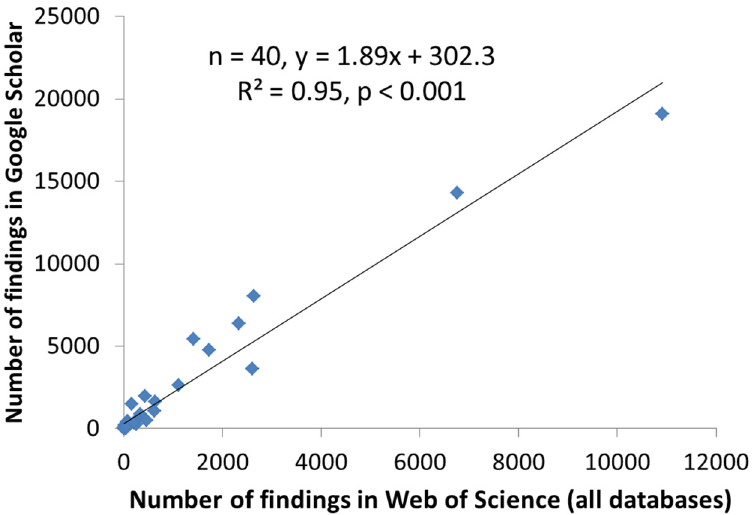
Figure 4. Correlation between number of findings in Google Scholar and Web of Science on the exotic tree pathogens reported in Switzerland up to October 2011 (as in [89], data kindly provided by Ottmar Holdenrieder, with addition of Hymenoscyphus fraxineus , the causal agent of ash dieback; searching for just this current name [90] will generally not retrieve publications only using the previous name Hymenoscyphus pseudoalbidus or the name of its anamorph, Chalara fraxinea ).